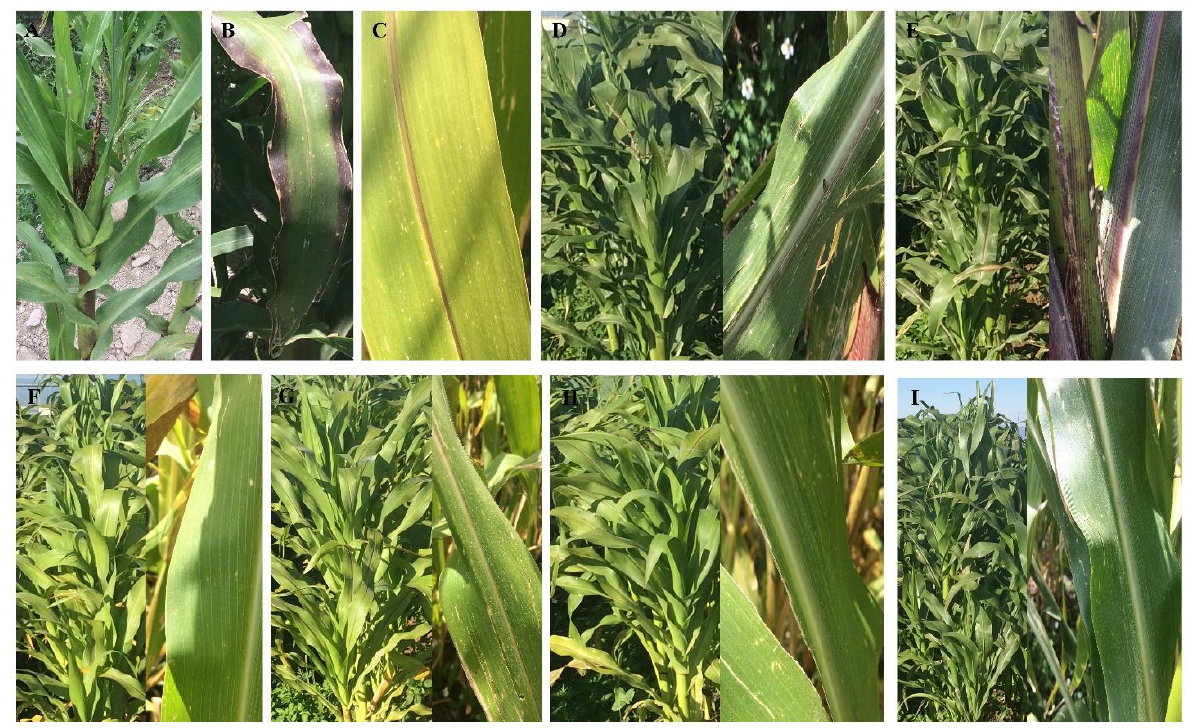
Figure 3. Purple corn plants of the Kculli race, at 103 days of growth. Treatment T1, plants with light green leaves, with white interveinal chlorosis that progresses from the tip to the base of the leaves, due to a deficiency of Mg ( A ); leaf with a coloration that goes from light green in the center to purple on the edges, due to a deficiency of P ( B ); light green leaf due to N and K deficiency ( C ); treatment T2, plants with dark green leaf coloration ( D ); treatment T3, plants with dark green growth and leaf coloration, without symptoms of nutrient deficiency ( E ); treatment T4, plants with light green leaf coloration and with new leaves with whitish yellow interveinal chlorosis, due to K and Zn deficiency ( F ); treatment T5, plants with light green leaves, with light yellow chlorosis in the old leaves, due to K deficiency ( G ); treatment T6, plants with a general loss of the healthy dark green color of the foliage, due to lack of K ( H ); and treatment T7, plants with adequate development and dark green leaf color, without signs of macro and micronutrient deficiency ( I ).